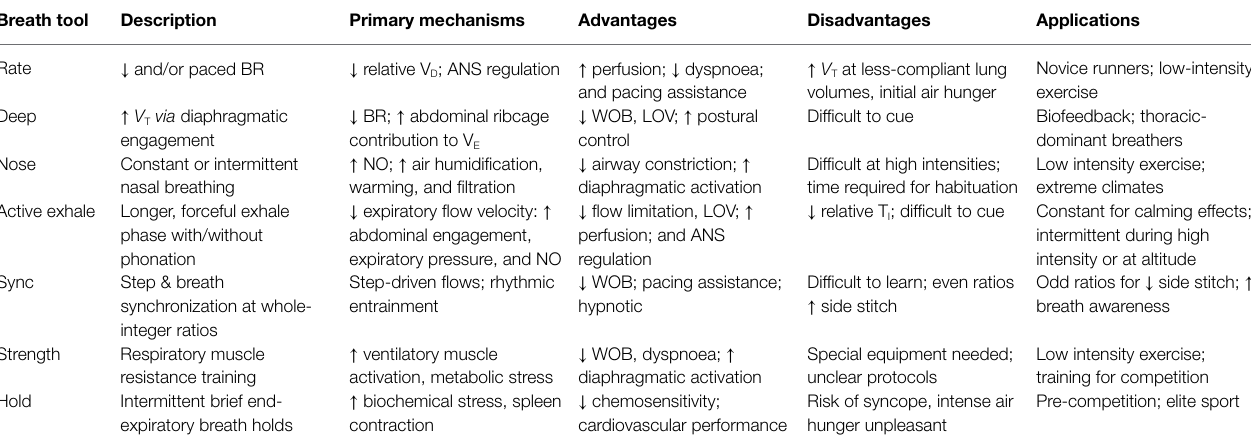
TABLE 3 | Overview of breath tools strategies description and